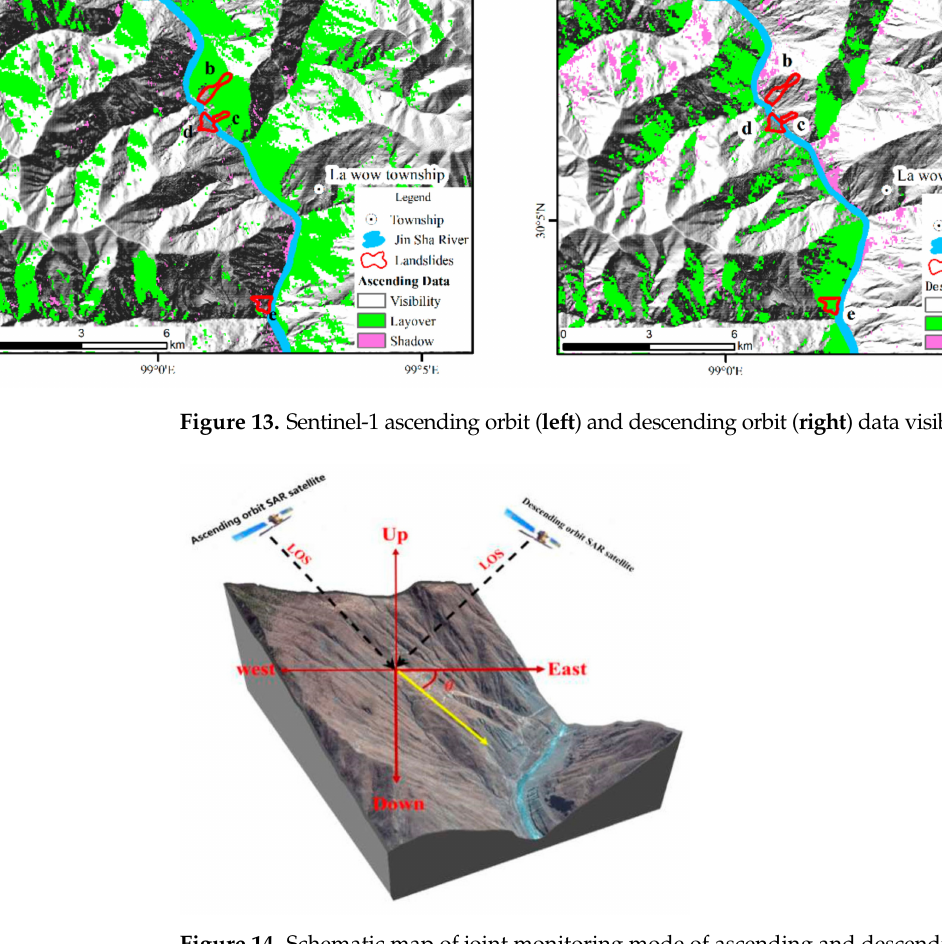
Figure 14. Schematic map of joint monitoring mode of ascending and descending orbit data. ( θ is the incidence angle of the